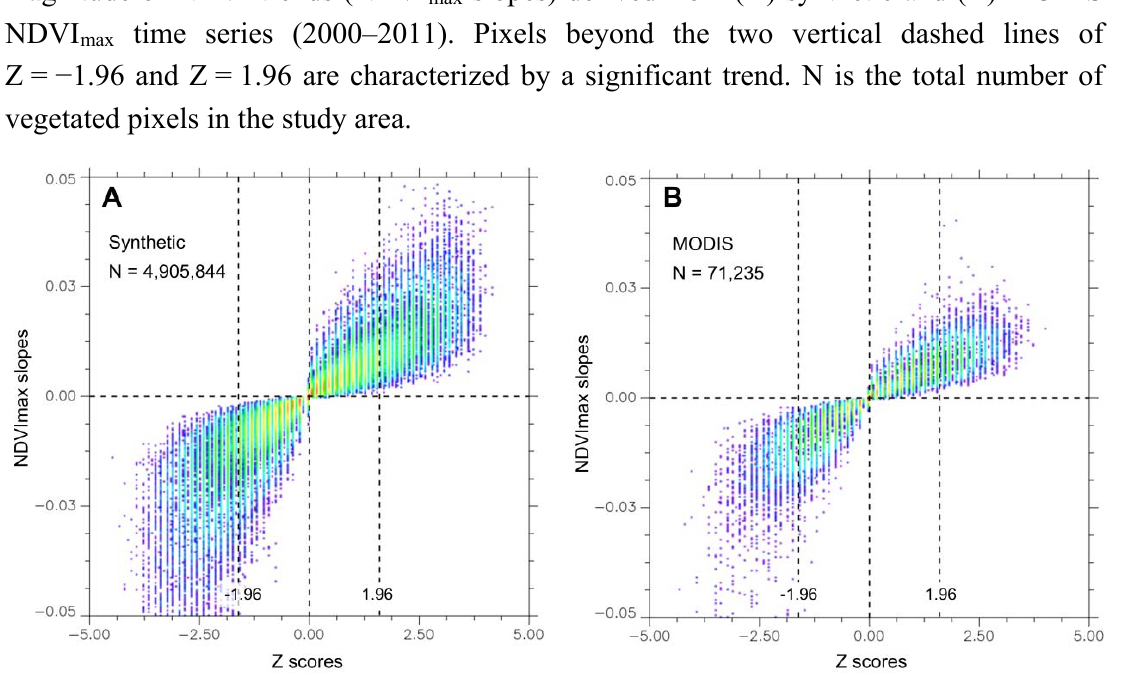
slopes derived from ( A ) synthetic max